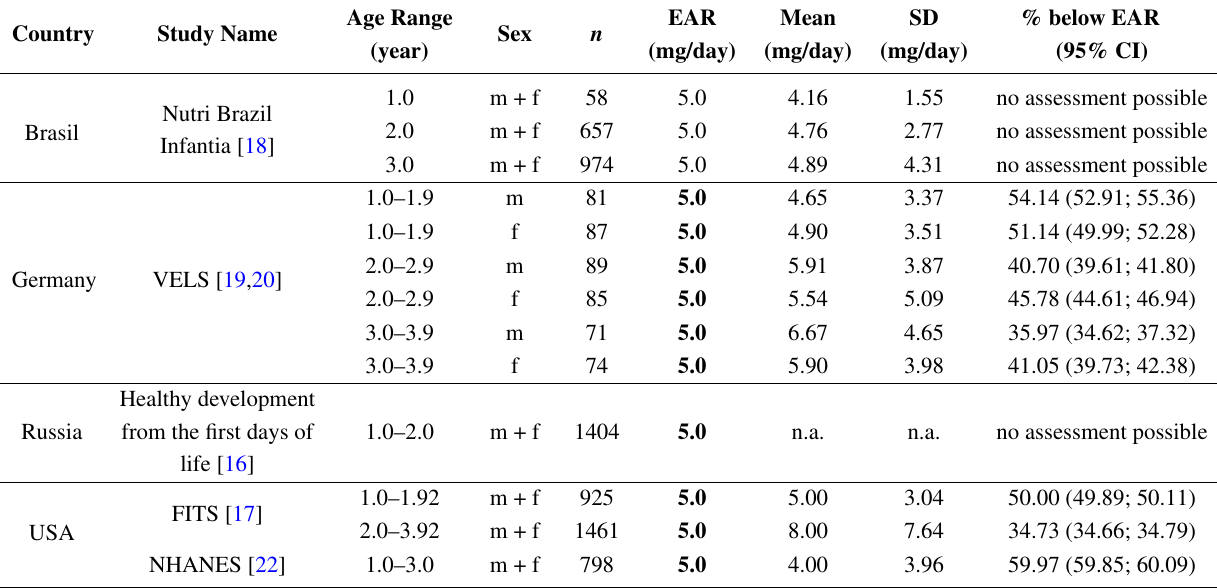
Table 4. Mean vitamin E intake (mg/day) and prevalence of inadequate intake (% below EAR) in Brazil, Germany Russia and the United States.